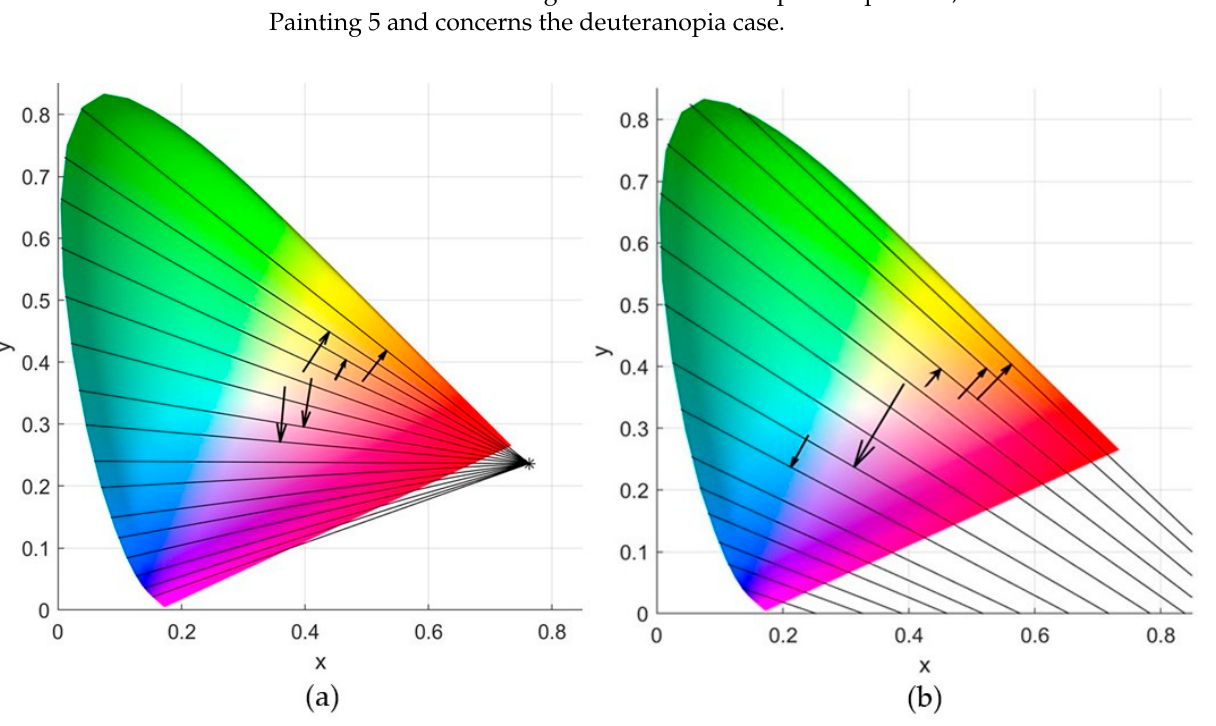
Figure 6. Translation process (see Algorithm 1) for the confusing key colors: ( a ) Painting 1 for the protanopia case; ( b ) Painting 5 for the deuteranopia case.